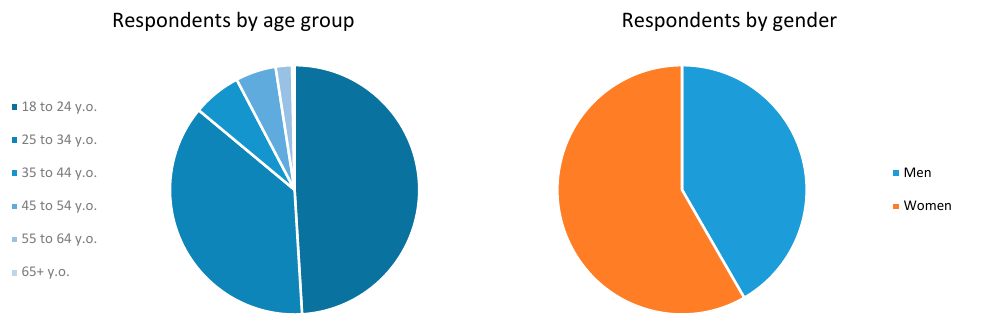
Figure 2. Respondents by age group and gender.